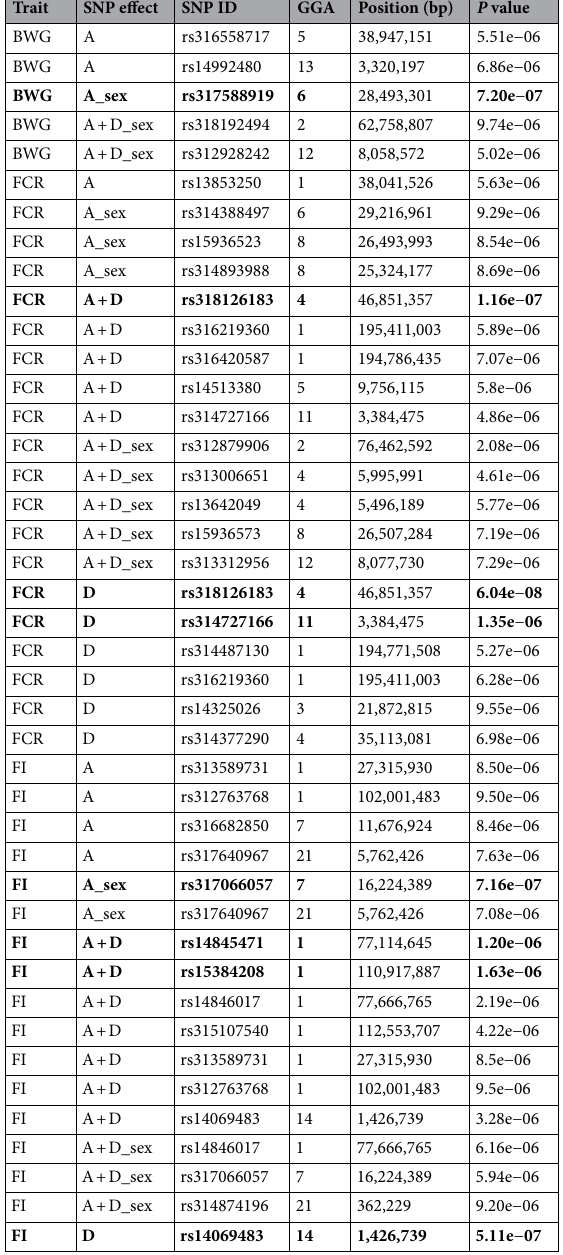
Table 3. SNPs with 5% genome-wide significance (in bold) and with moderate association with body weight gain (BWG), feed conversion ratio (FCR) and feed intake (FI) traits identified with different SNP effects fit in the